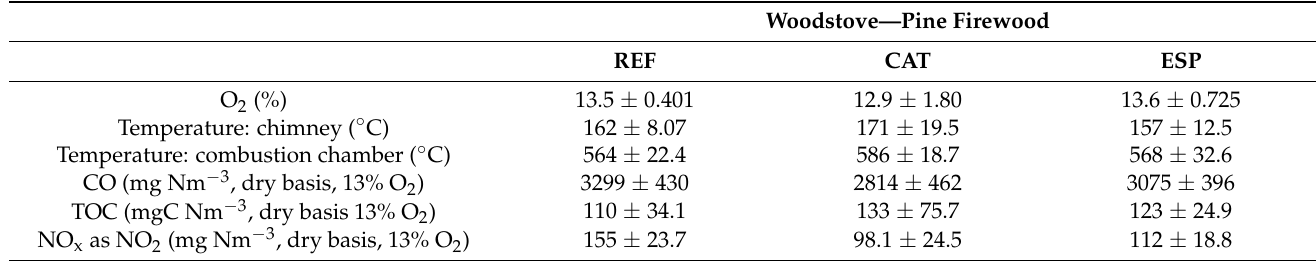
Table 2. Operating parameters of the woodstove and CO, TOC, and NO x emission concentration at 13% of